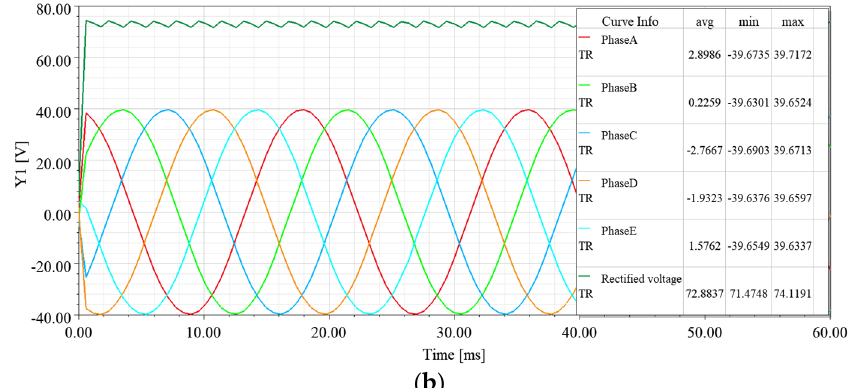
Figure 22. Input voltage and rectified voltage; ( a ) three-phase full-wave rectifier, ( b ) five-phase uncontrolled rectifier.